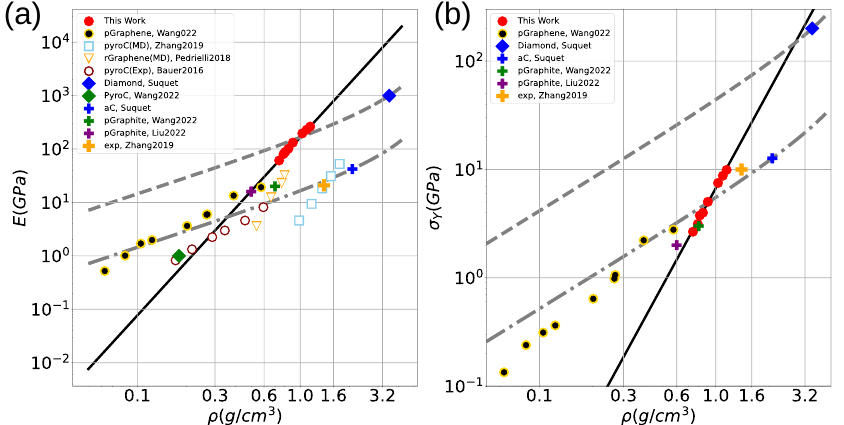
Figure 5. ( a , b ) show Young’s modulus and yield stress compared with other related works. Both upper and lower dashed lines correspond to the theoretical limit (Suquet equation) of di- amond and graphite porous materials as a function of the density. The red points correspond to our simulation results. Points correspond to experiments and MD simulations provided by refs. [12,13,31,36,37,61].